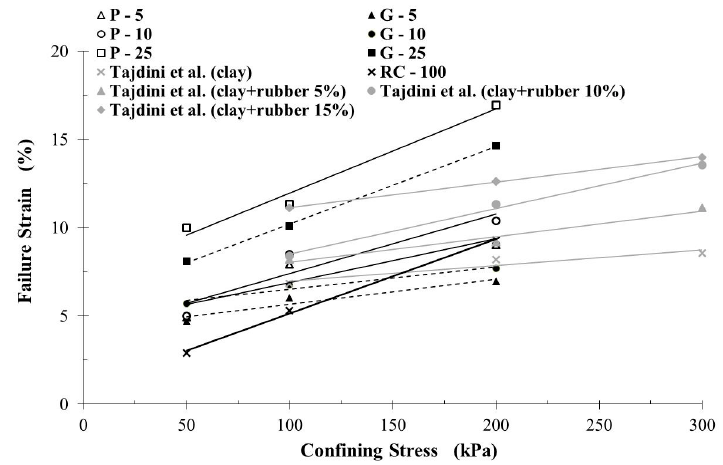
Figure 9. Strain at failure versus confining stress for (RCR) mixtures and for the clay and clay-crumb mixtures (based on this study and Tajdini et al.’s tests [31]).